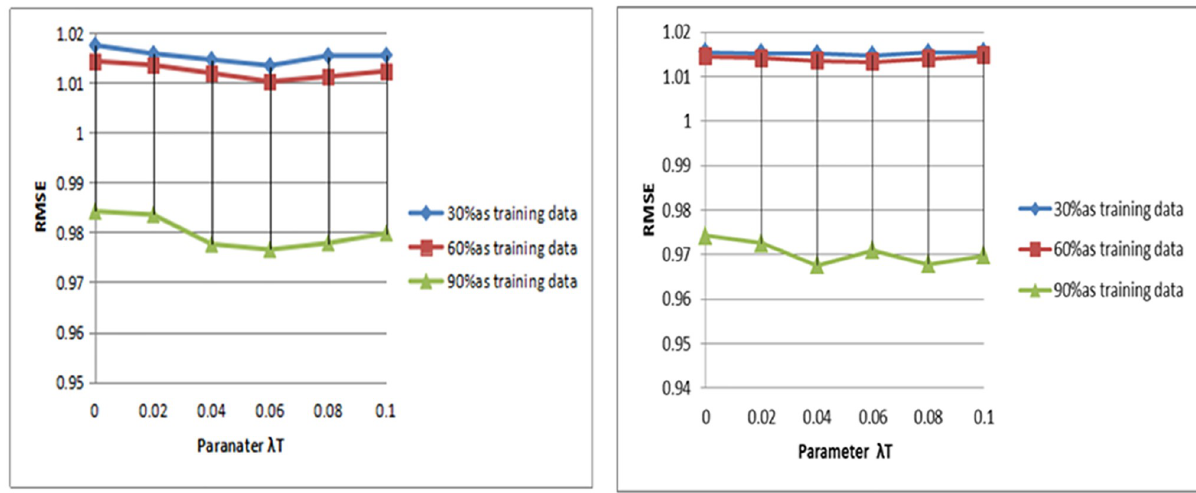
Fig 8. Parameter analysis of Epinions.